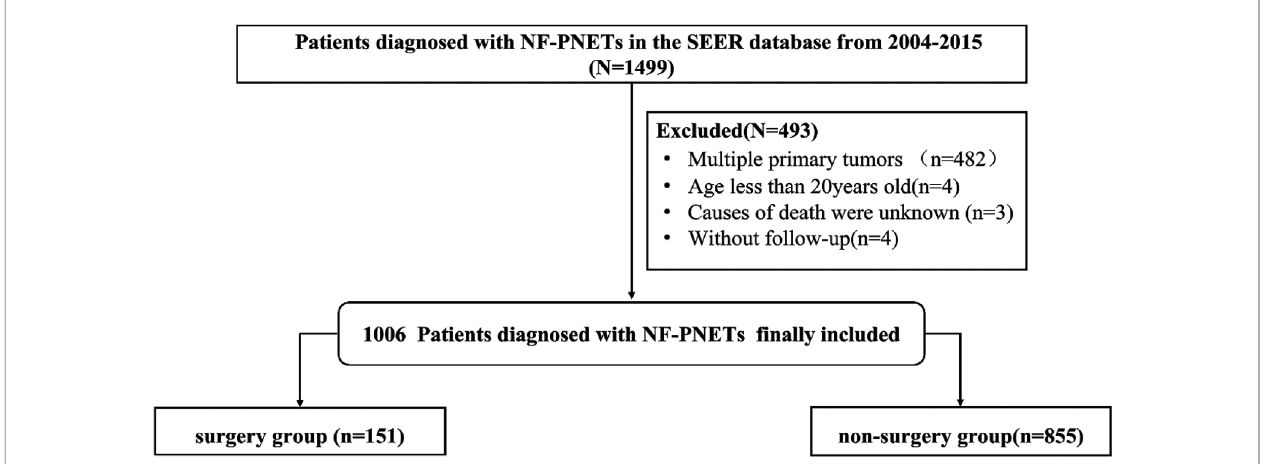
FIGURE 1 | Flowchart of patient selection from the Surveillance, Epidemiology, and End Results